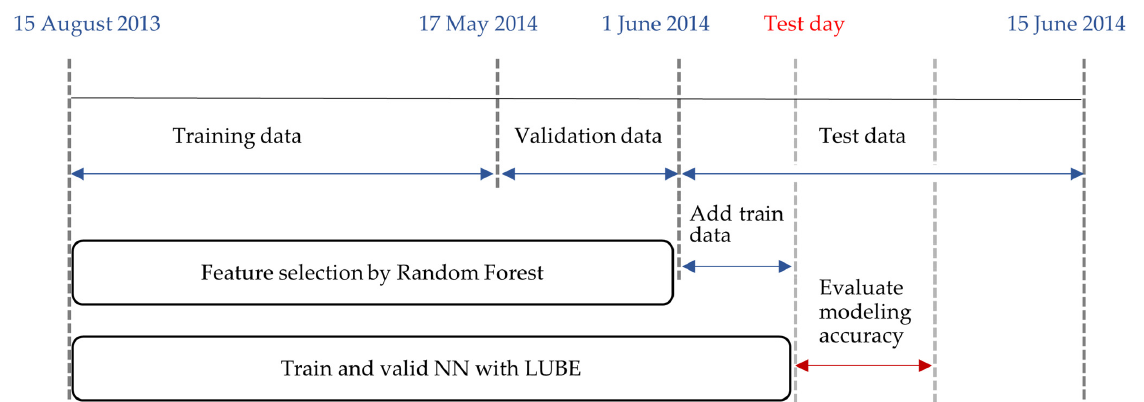
Figure 3. Lower upper bound estimation method with random forest.